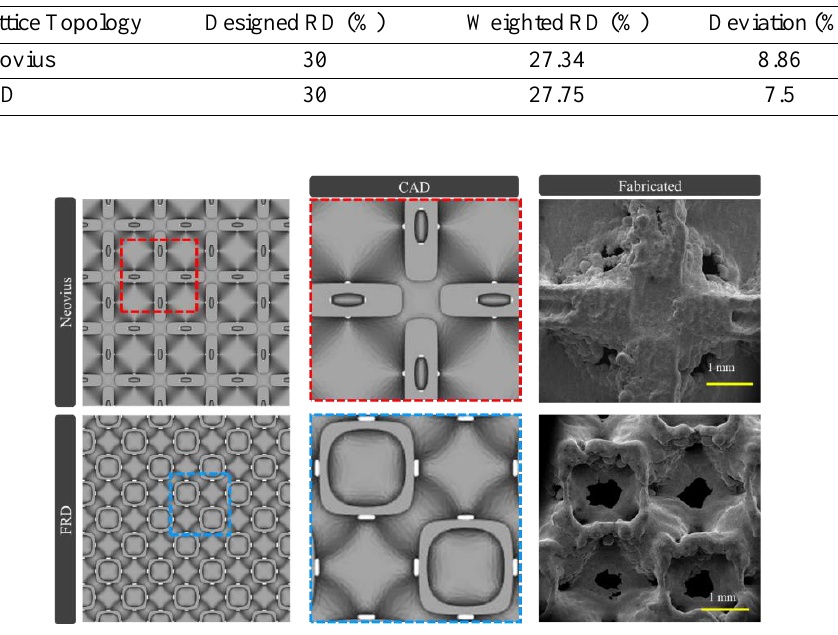
Fig. 4 . SEM images of Neovius and FRD showing the printing quality of the printed